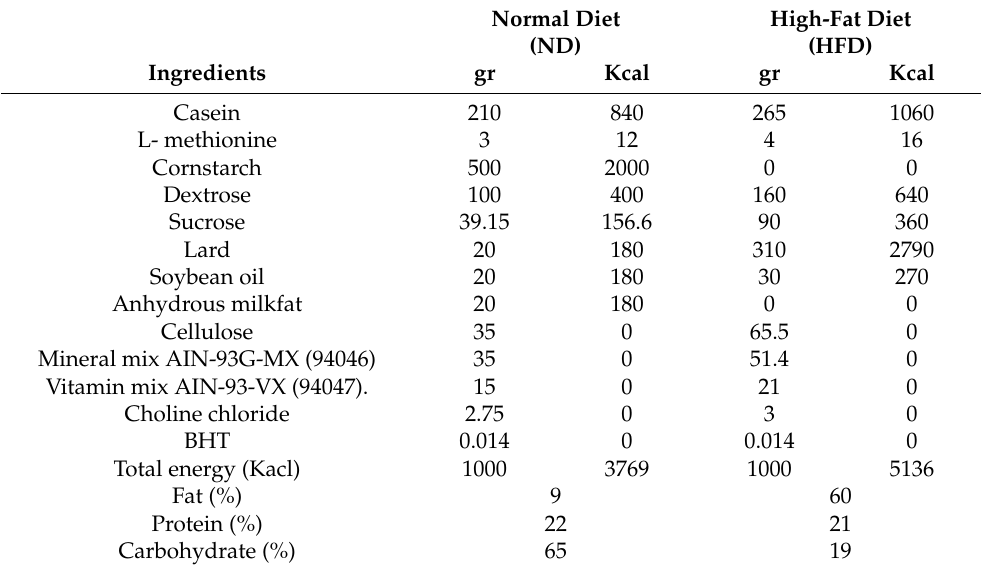
Table 1. Compositions of animal